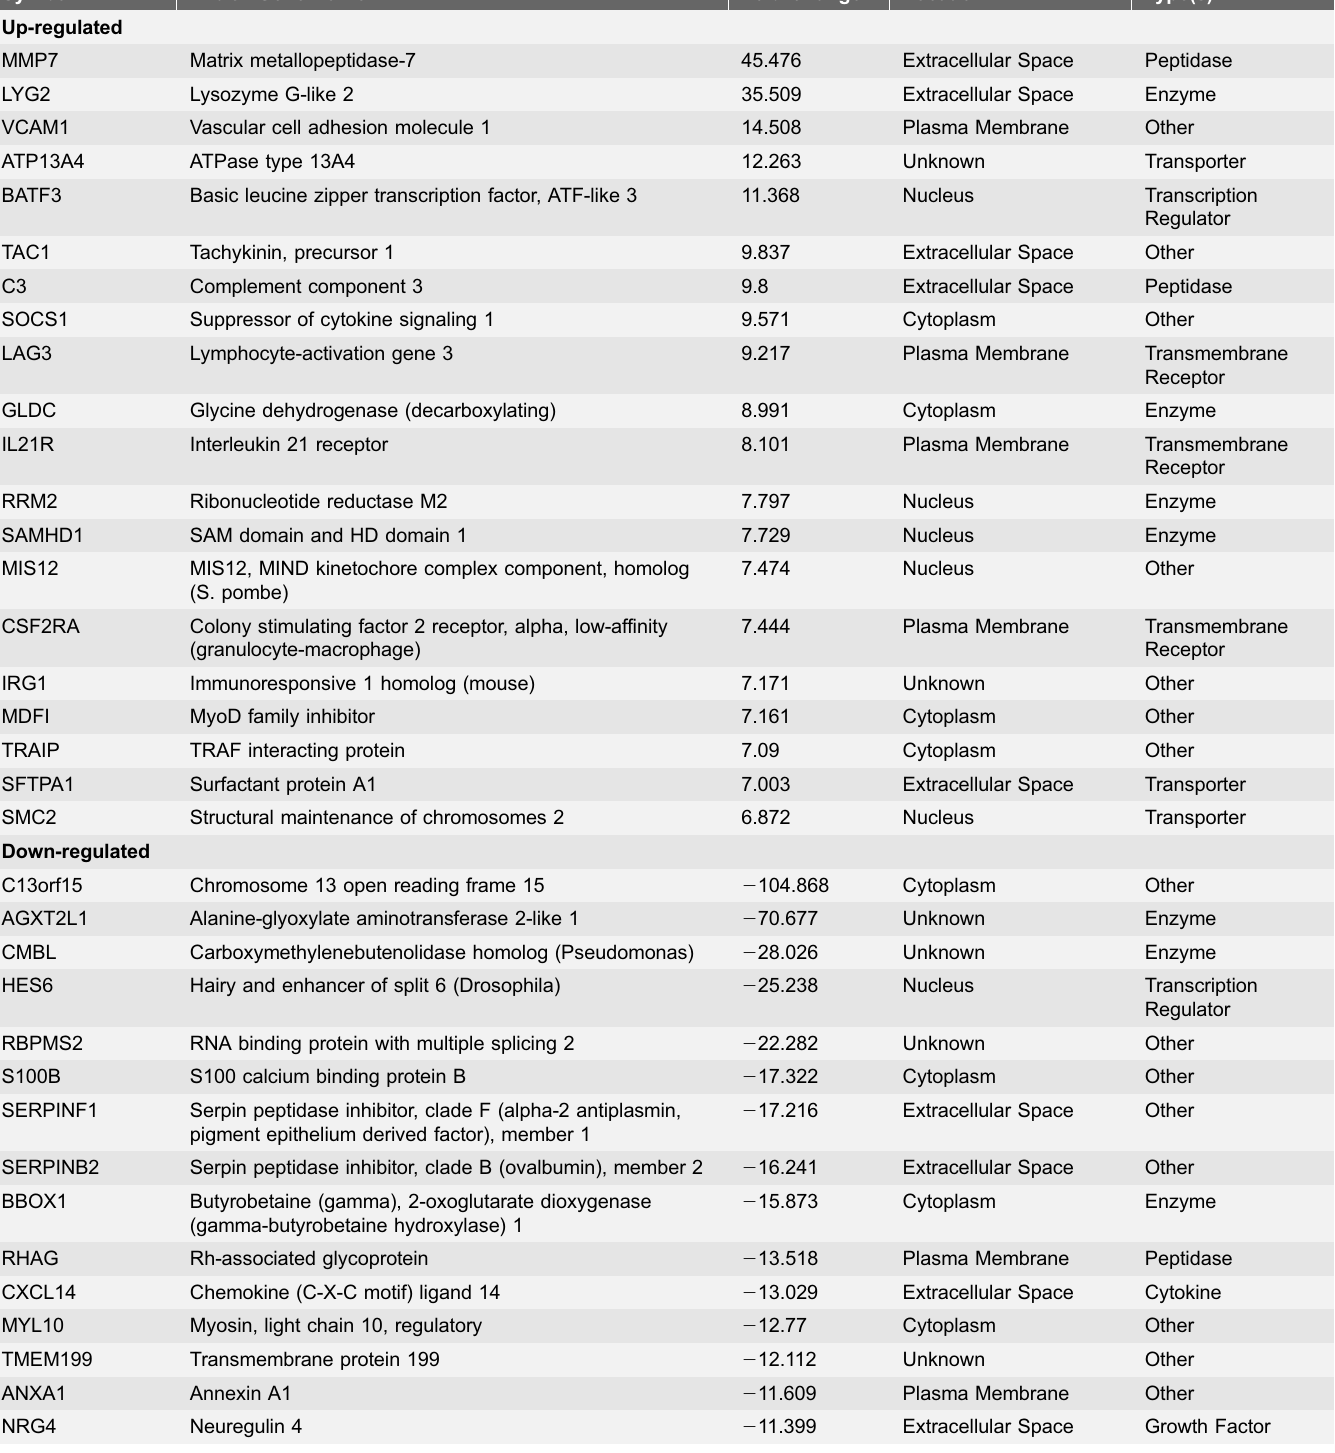
Table 2. The 20 most up-regulated and 20 most down-regulated intestinal IEL transcript levels in C. perfringens / E. maxima co-infected Ross chickens compared with uninfected controls.